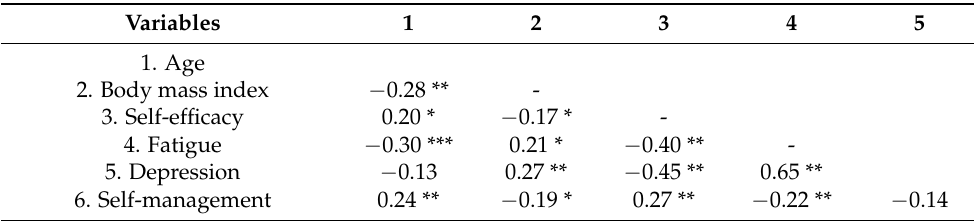
Table 4. Correlation